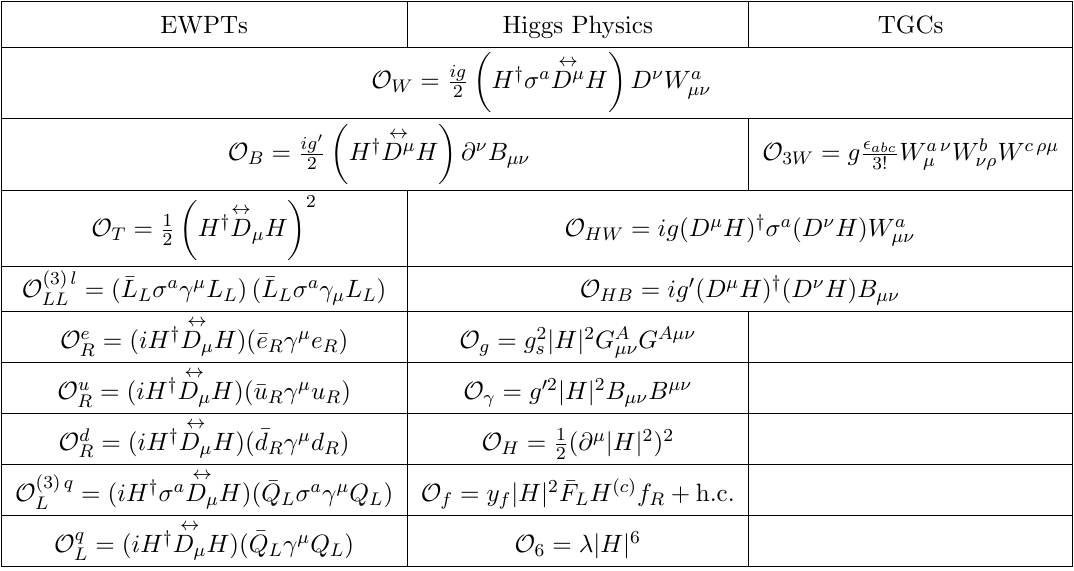
Table 1 . List of pertinent CP-even dimension-6 operators in the basis [18] that we use. In each case we recall the categories of observables that provide the greatest sensitivities to the operator, possibly in combinations with other